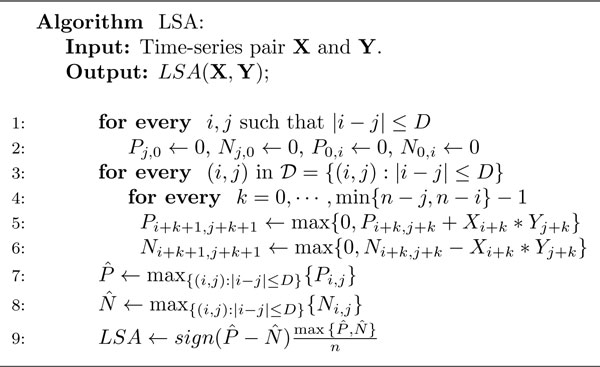
The LSA algorithm. Algorithm for computing the LSA for a pair of time series X and Y. D  denotes the set i,j:i,j∈ℕ+, eitheri= 0 orj=0 andi-j≤D and ℕ+  denotes the set of positive integers.